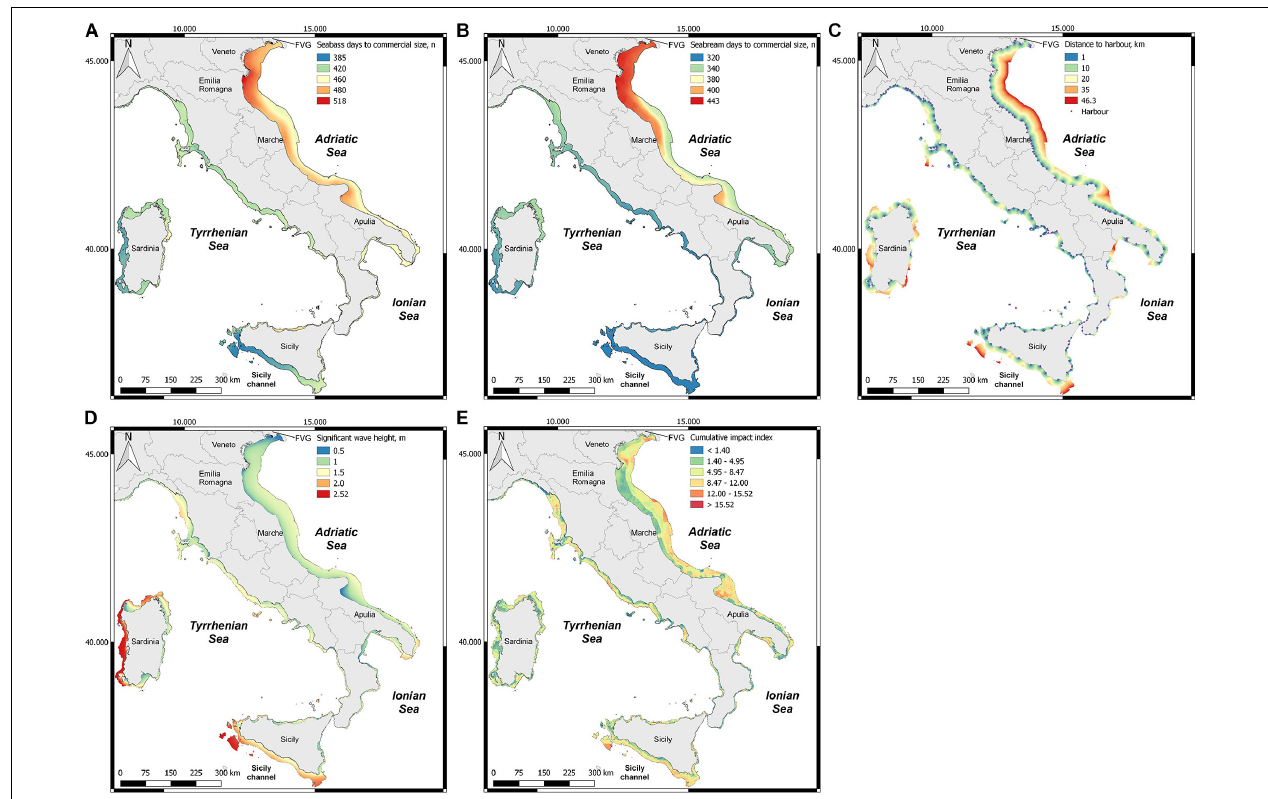
FIGURE 6 | Maps of criteria considered in the analyses. (A) Days required by seabass to reach the commercial size. (B) Days required by seabream to reach the commercial size. (C) Distance to harbor. (D) SWH. (E) Cumulative impact within the study area.